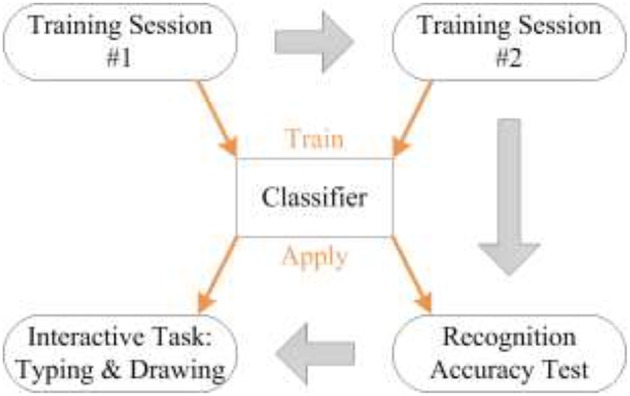
Cascade of experimental procedures.